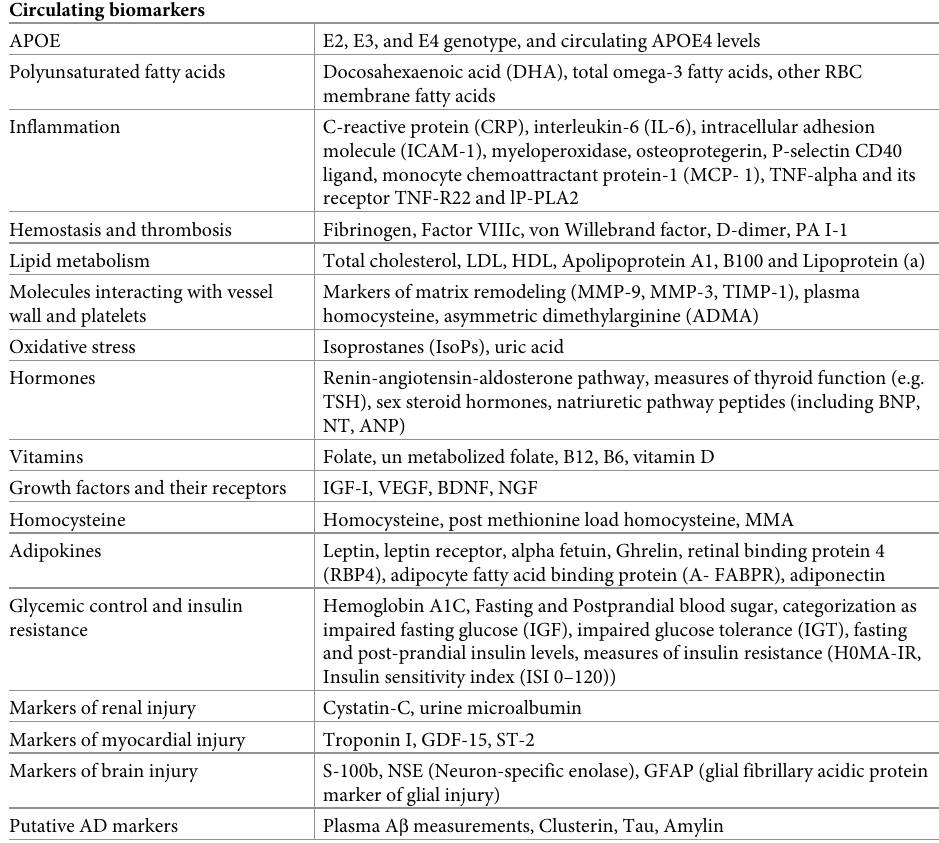
Table 3. Partial list of available biomarkers in